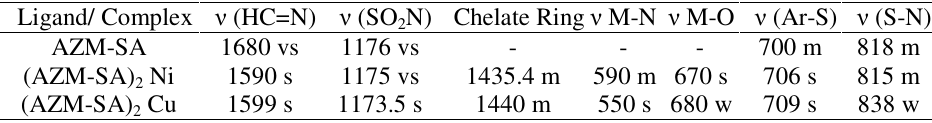
Table 3. Infrared spectral data (cm -1 ) and their tentative assignments